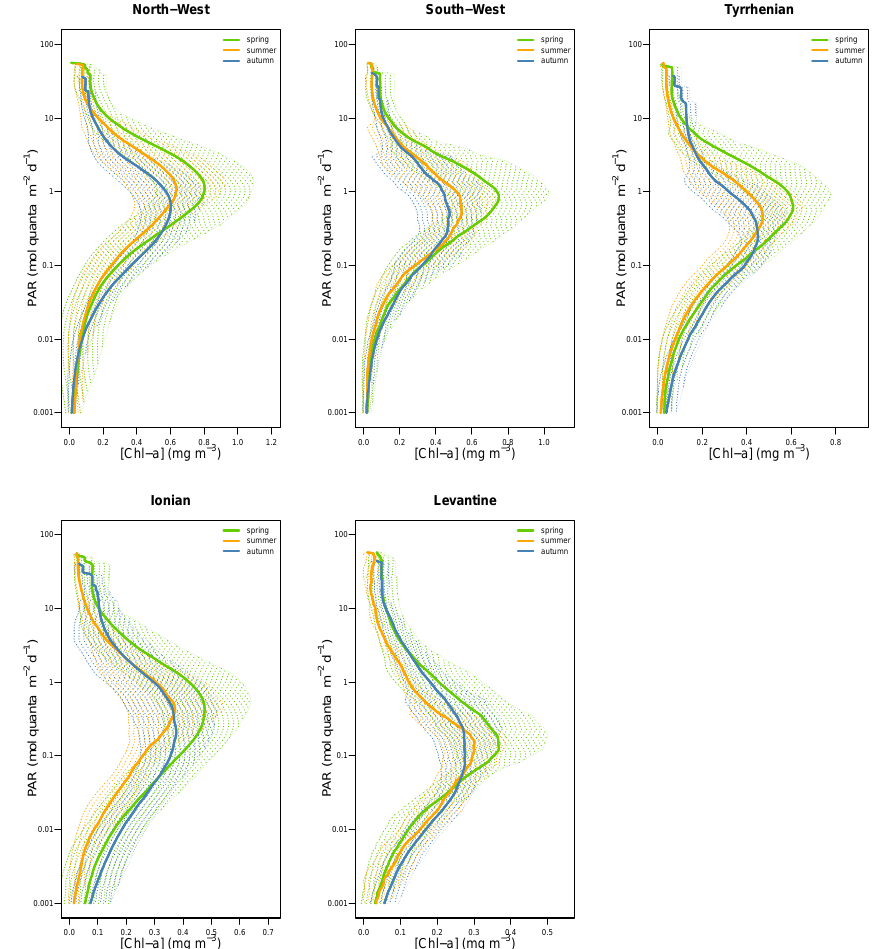
Figure 10. Averaged vertical distribution of [Chl a ] as a function of PAR with standard deviation (dotted area). Spring refers to the April–June period, summer to July and August, and autumn to the September–November